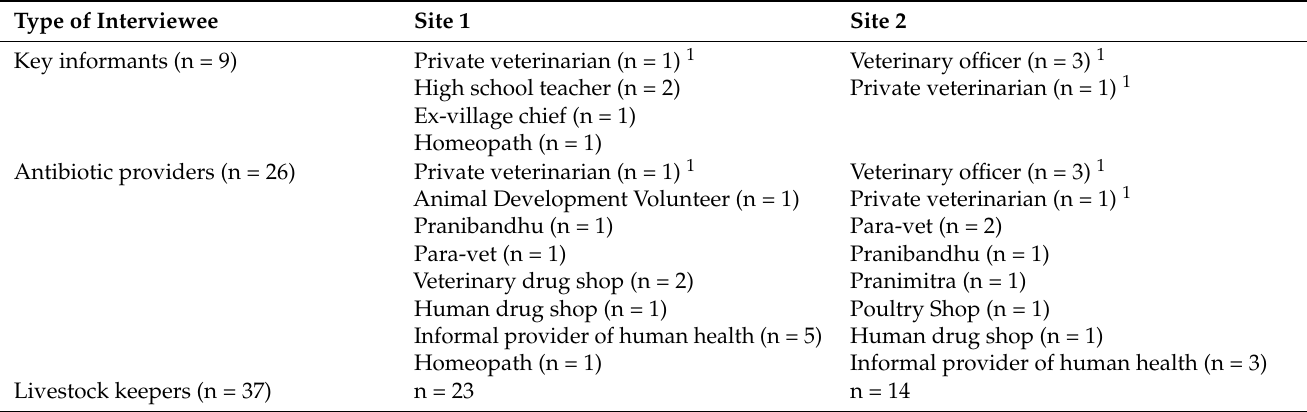
Table 1. Summary of the participants interviewed (n =